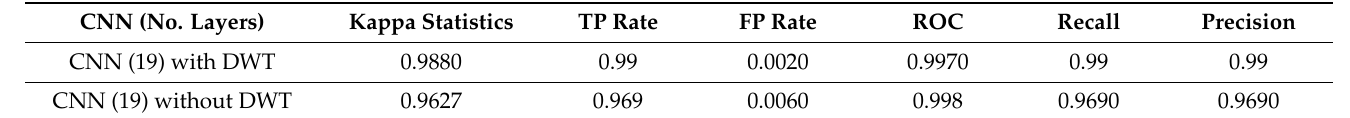
Figure 11. Overall accuracy of CNN with respect to training and testing ratios. Table 8. Performance measurement of CNN with and without DWT.